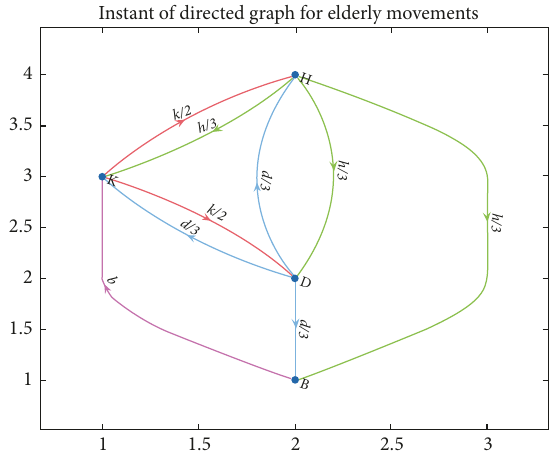
Figure 2: An example of weighted directed graph representation for the reference key nodal sensing points shown in Figure 1. Figure 2 is reproduced from Payandeh, 2018 [11] (under the Creative Commons Attribution License/public